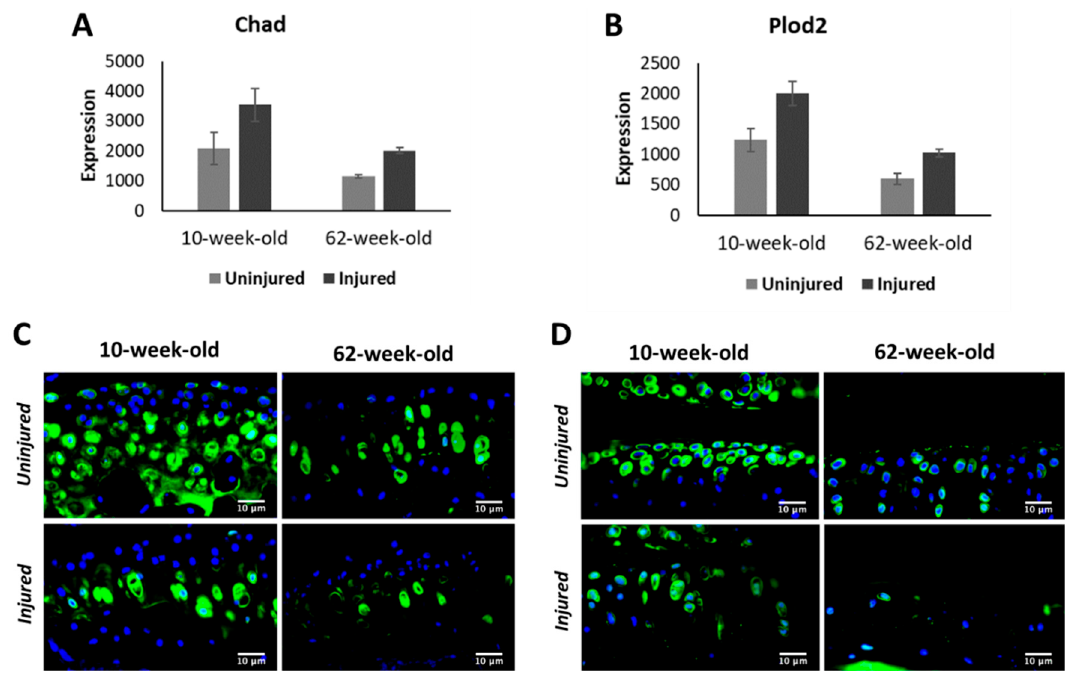
Figure 5. Chad ( A ) and Plod2 ( B ) gene expression at six-week post injury in 10-week-old and 62-week-old mice. Chad ( C ) and Plod2 ( D ) protein expression in 10-week-old and 62-week-old mice Green: protein staining. Blue: DAPI staining marking the nucleus. (40× magnification).